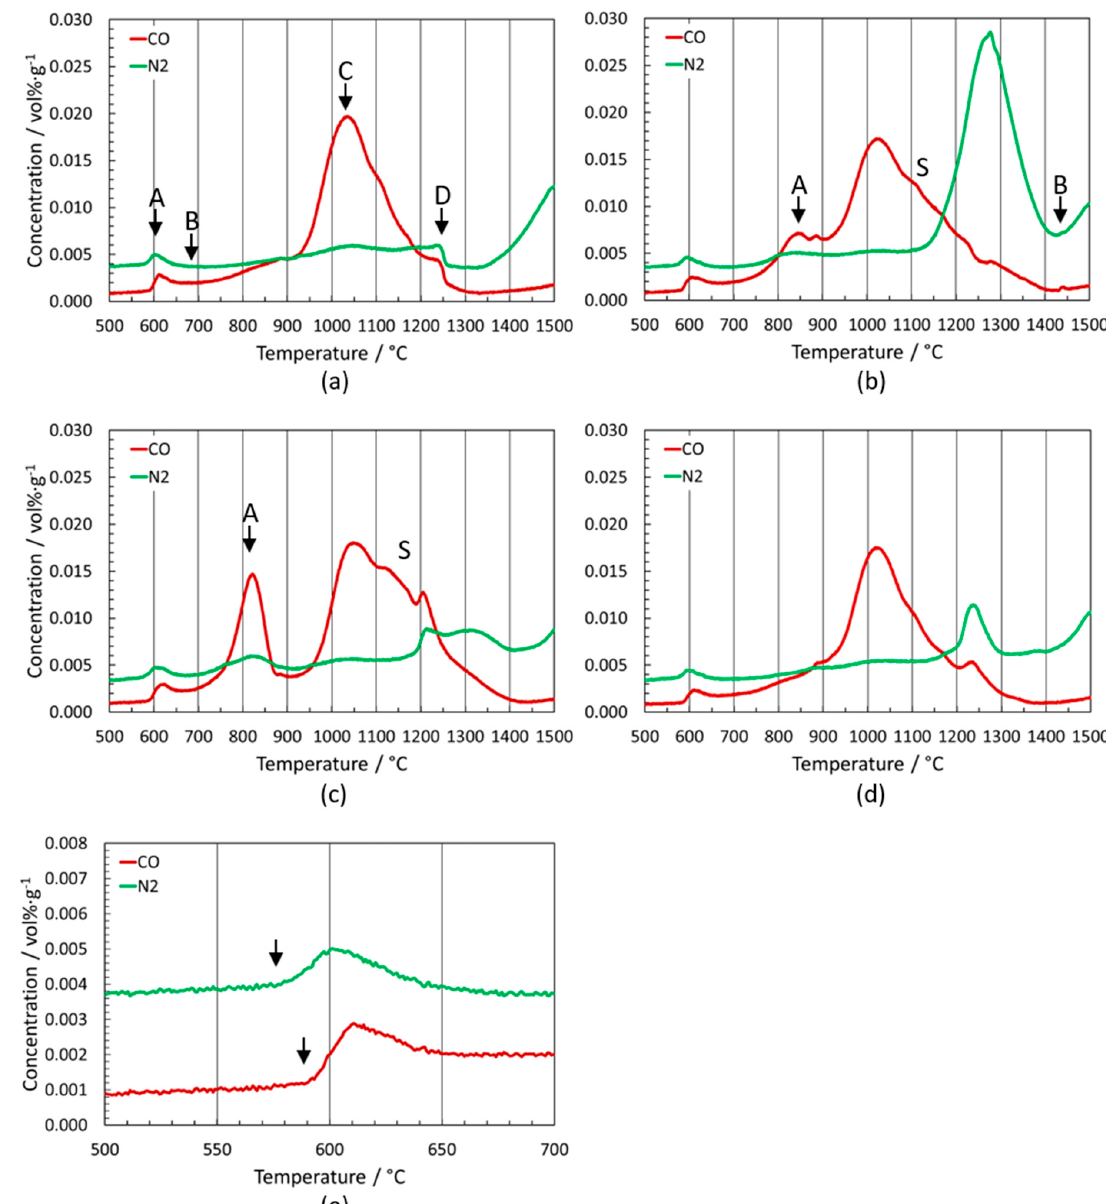
Figure 1. CO (red lines) and N 2 (green lines) outgassing of model alloys. ( a ) Ti(C,N)-Co/Ni, ( b ) Ti(C,N)-WC-Co/Ni, ( c ) Ti(C,N)-Mo 2 C-Co/Ni, ( d ) Ti(C,N)-(Ta,Nb)C-Co/Ni, ( e ) magnification of the outgassing of the binder phase.